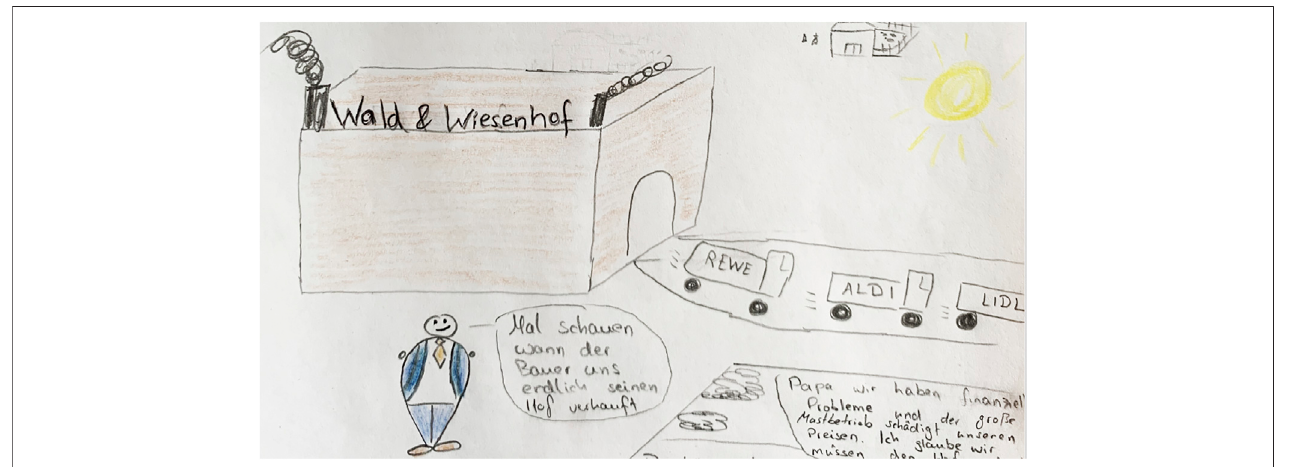
FIGURE 6 | Emotional link between a small and a big farm sharing a common space. Spatial relations resonate in this image but the author does not make them explicit.Thetextintheimagereadsasfollows: “ CountryFarm ” ,namesofsupermarketchainsonthetrucks, “ Let ’ sseewhenthefarmer fi nallysellshisfarm. ” , “ Daddy,we have fi nancial issues, and the huge pig mast farm is destroying our prices. I ’ m afraid we have to sell our farm. ” Image courtesy of D.